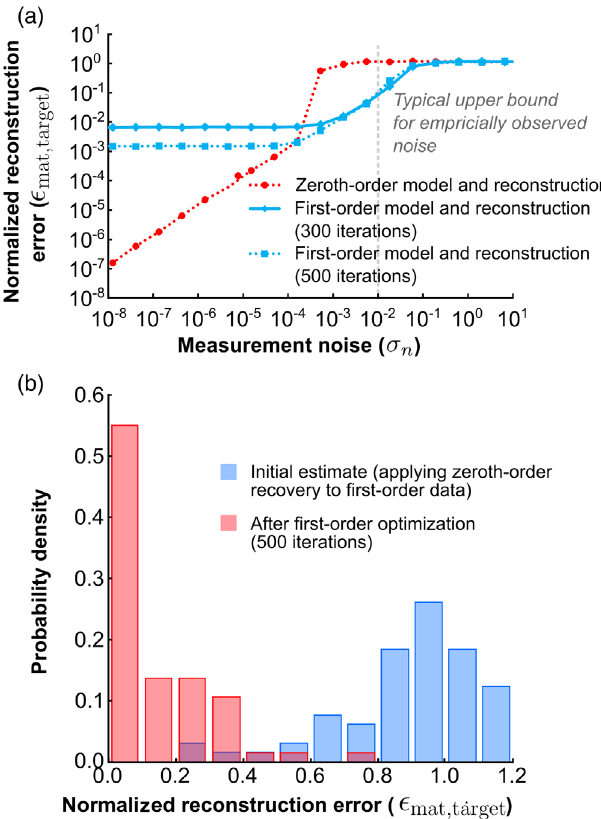
FIG. 5. Impact of measurement noise and different perturbation conditions on recovery. (a) Error in reconstructed images for different levels of noise in measured quantities ( ϵ and σ n mat ; target are defined in Sec. III D). At low noise levels, the error of the first-order model is seen to be limited by the number of iterations, but at higher noise levels, it converges to a trend consistent with the zeroth-order model. The first-order approach is more robust at higher noise levels due to the use of iterative optimization. A typical upper bound for noise encountered experimentally [4] is indicated to show that recovery from real experimental data is feasible. (b) Histogram showing the effect of 200 different random TM realizations, i.e., different fiber perturbations, under the first-order model. The error after the initial estimate (gen- erated by applying zeroth-order recovery to the first-order data) FIG. 6. First-order recovery of an experimentally measured can be large ( > 1 ), but after 500 iterations of Algorithm 1, 50% of MCF TM. (a) Original TM using data from Ref. [4] and the first- TMs have errors less than 0.1 and 95% have errors less than 0.4. order recovered TM, showing high visual similarity, which The r vector used to determine ϵ is a random complex indicates successful recovery. (b) Proportional elementwise error target mat ; target in TM reconstruction (maximum less than 10 − 3 unit vector.